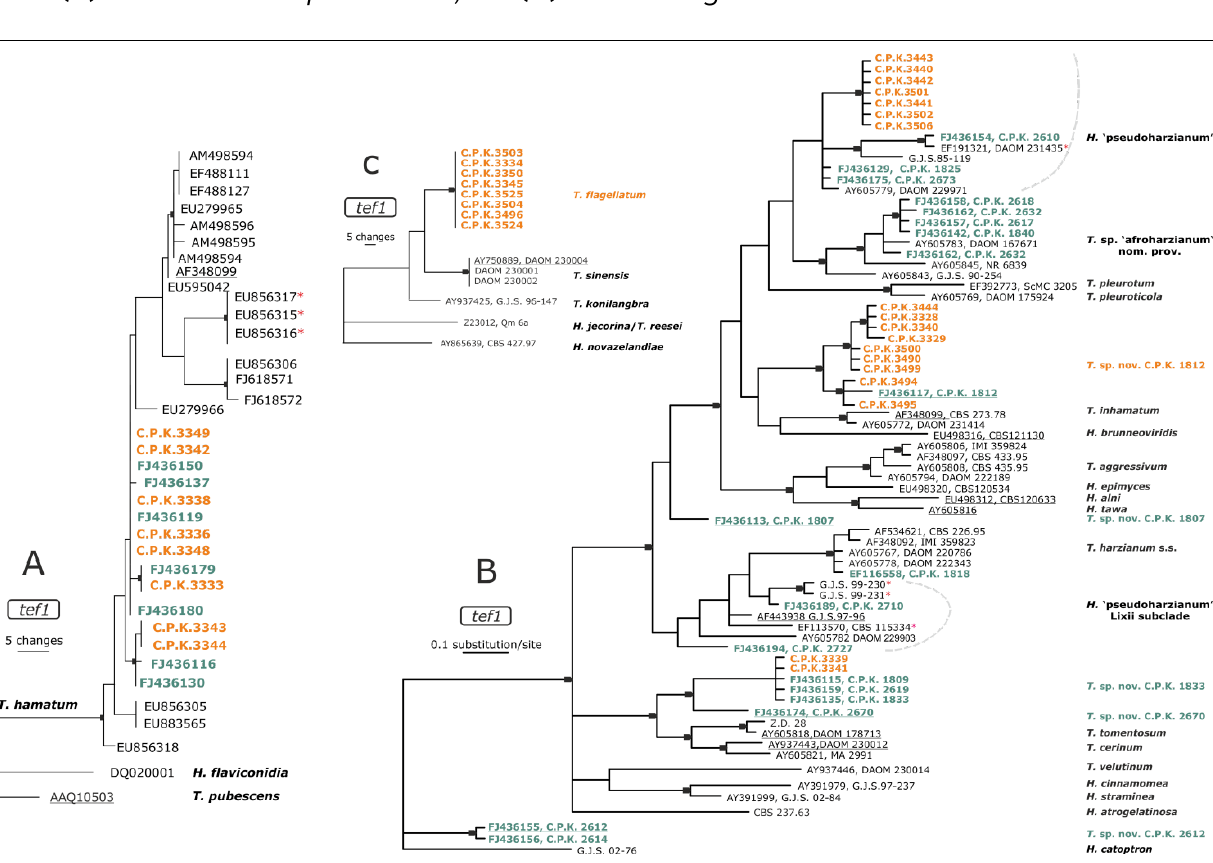
Figure 1. Phylogeny of endophytic Trichoderma strains isolated from coffee ( Coffea arabica ) roots inferred by maximum parsimony (MP) ( A , C ) and Bayesian (MB) analyses ( B ). Nodes supported by bootstrap values for MP of >74% or posterior probabilities for MB>0.94 respectively are indicated by black arrows. The color code indicates isolates associated with C. arabica as green for strains that were isolated from the coffee rhizosphere [19] and orange for endophytic strains isolated in this study. Sequences of established type cultures are underlined; asterisks mark strains of African origin. ( A ) T. hamatum